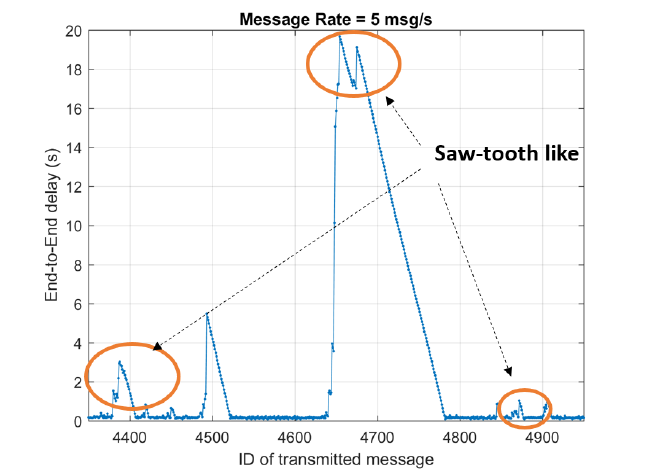
Figure 5. Examples of saw-tooth like behavior for the message generation rate of 5